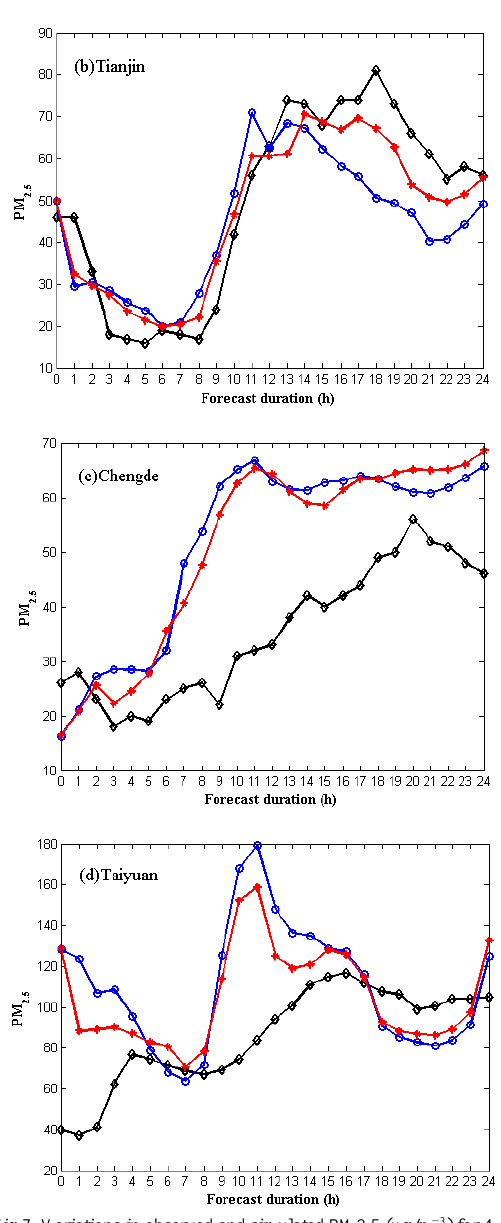
Fig.7. Variations in observed and simulated PM2.5 (µg/m −3 ) for 4~5 November 2017 (a)Beijing (b)Tianjin (c)Chengde (d) Taiyuan Table 1 Compare the assimilate experiments with global and regional BEC of main sites